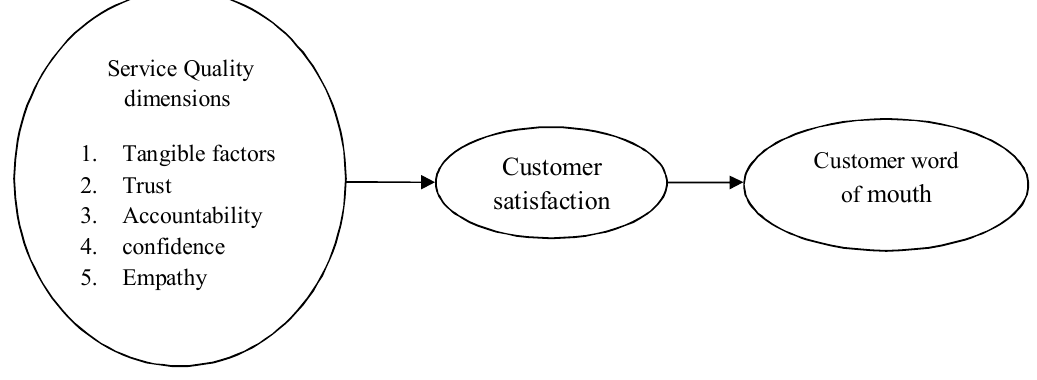
Fig. 1. Conceptual model (Ioannis & Constantine,